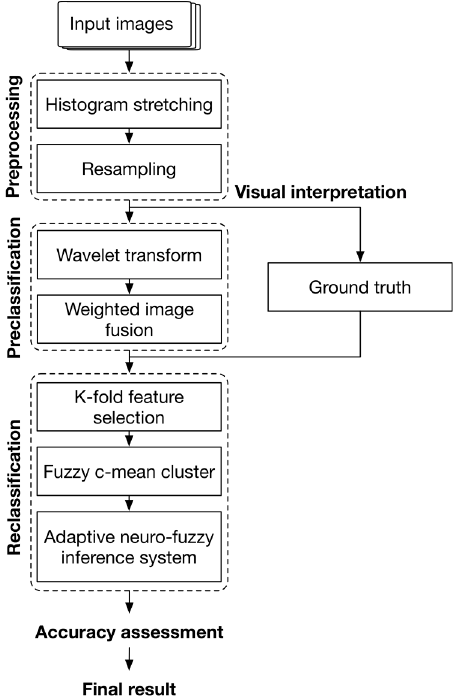
Figure 4. Workflow of the proposed method for counting large mammals from a single, very high resolution panchromatic GeoEye-1 satellite image.